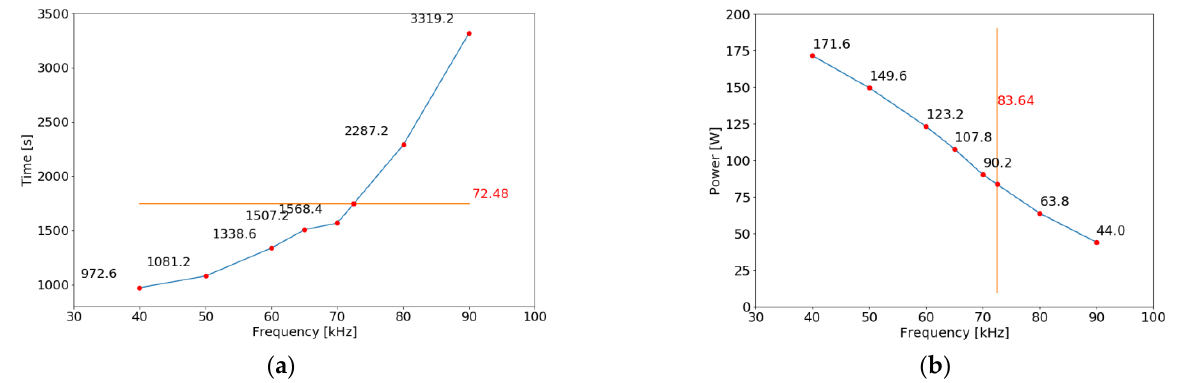
Figure 17. Determination of frequency and power used by a single RH device to melt ice piece at the same time as the RH device: ( a ) determination of frequency; ( b ) determination of power used.